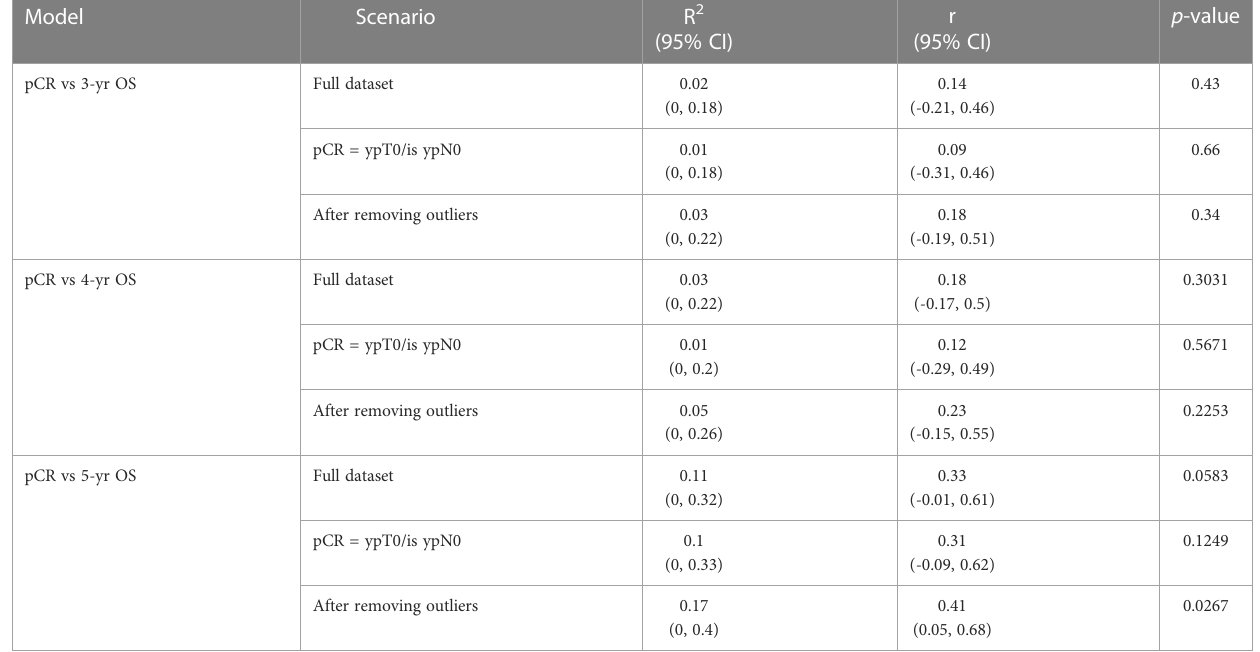
TABLE 1B Sensitivity analyses for OS at landmark time points vs.